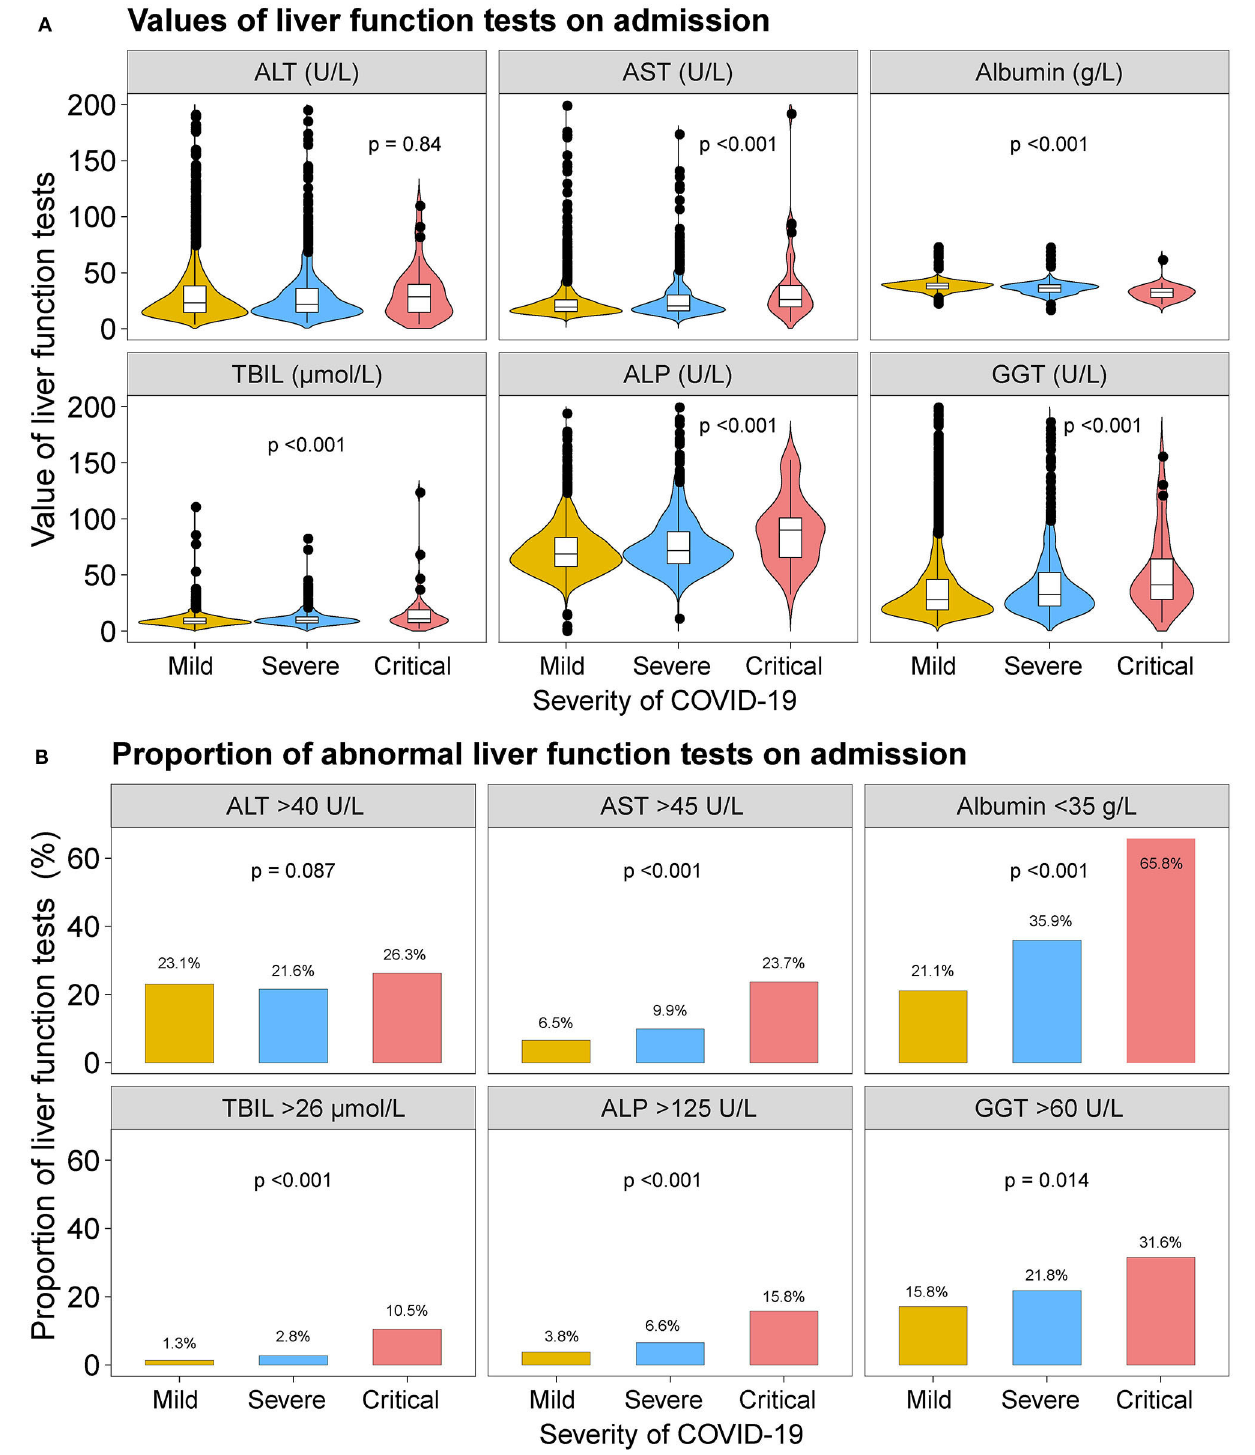
FIGURE 1 | Liver function tests on admission. (A) Violin and box plots showing the median values of ALT, AST, albumin, TBIL, ALP, and GGT by severity of the COVID-19 disease. (B) Bar plots showing the proportion of abnormal ALT, AST, albumin, TBIL, ALP, and GGT tests on admission by severity of the COVID-19 disease. ALT, alanine aminotransferase; AST, aspartate transaminase; ALP, alkaline phosphatase; GGT, gamma-glutamyltransferase; TBIL, total bilirubin abnormal.